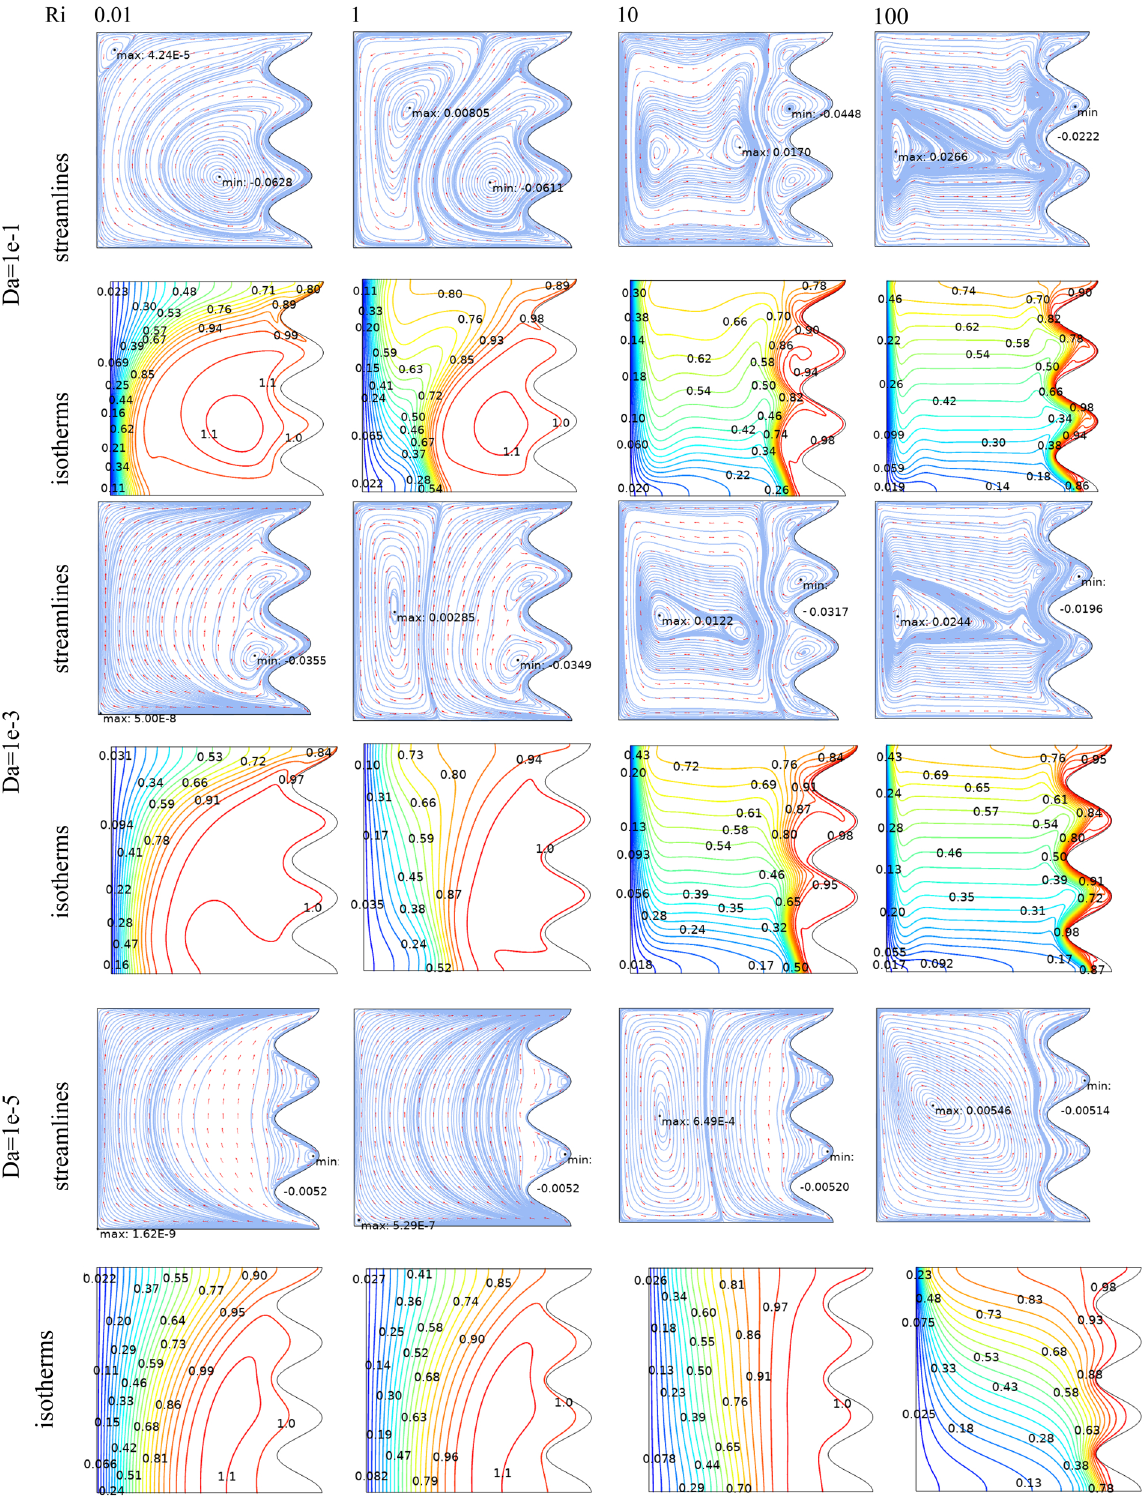
Figure 11. Streamlines and isotherms at (Re = 200, Q = 3, φ = 0.02, Ha = 20, γ = 45, A = 0.1) for Case